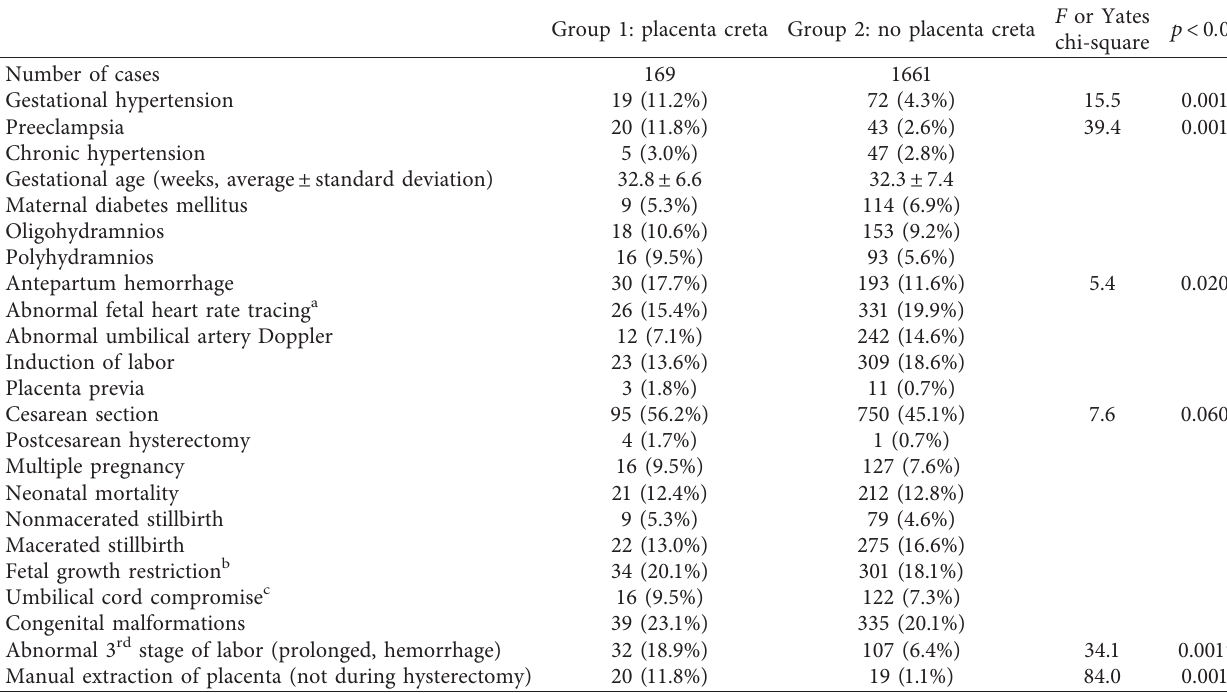
Table 1: Clinical phenotypes.